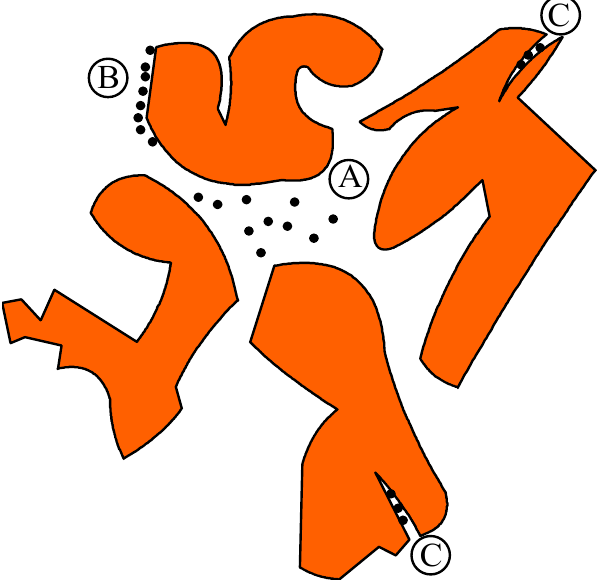
Figure 5. Conceptual representation of bioavailability and bio-accessibility of organic contaminants in soils.